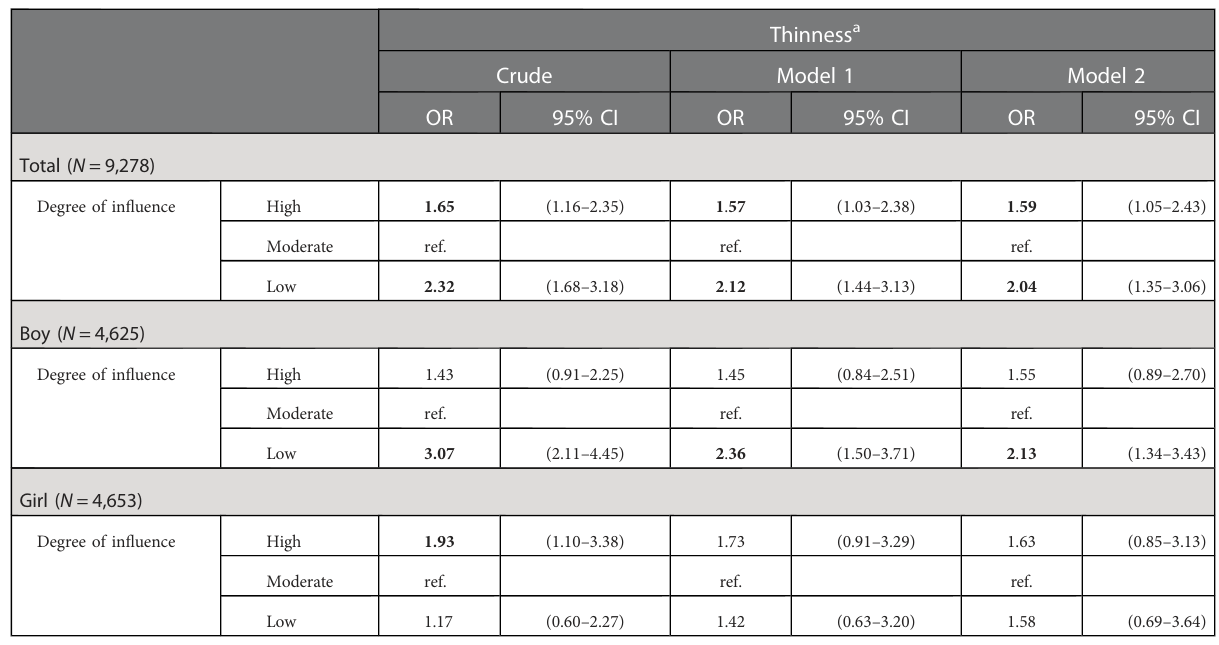
TABLE 2 The association between degree of in fl uence and thinness.